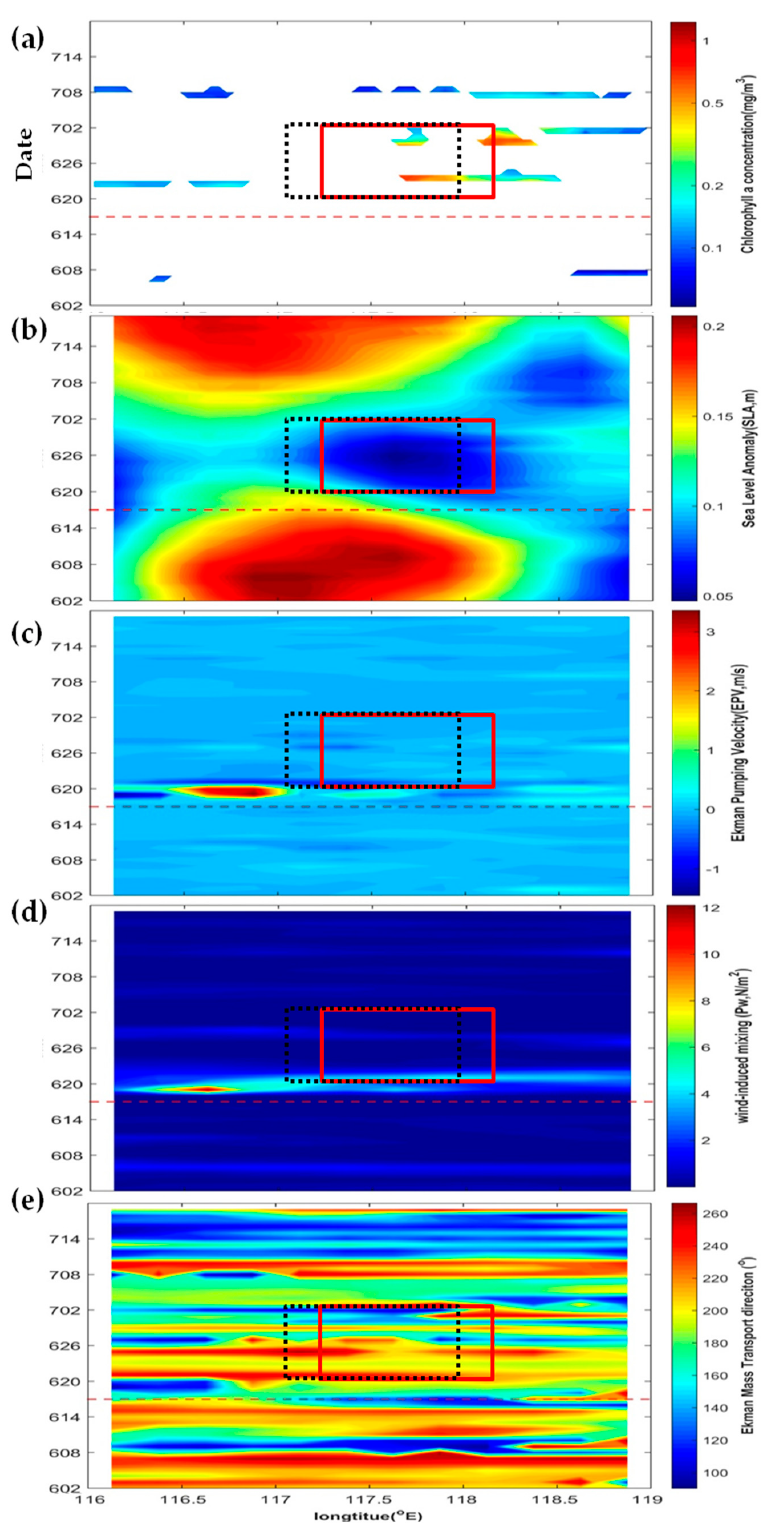
Figure 8. Horizontal time section of each parameter in the study area before and after the typhoon. ( a ) Chl-a (mg/m 3 ); ( b ) SLA (m); ( c ) EPV (m/s); ( d ) P w (N/m 2 ); ( e ) direction of the EMT (°); red dashed line represents the passage of the typhoon, the black dashed line box represents the position of the surface Chl-a blooms one week after the typhoon, the red box represents the position of the cyclonic eddy one week after the typhoon.